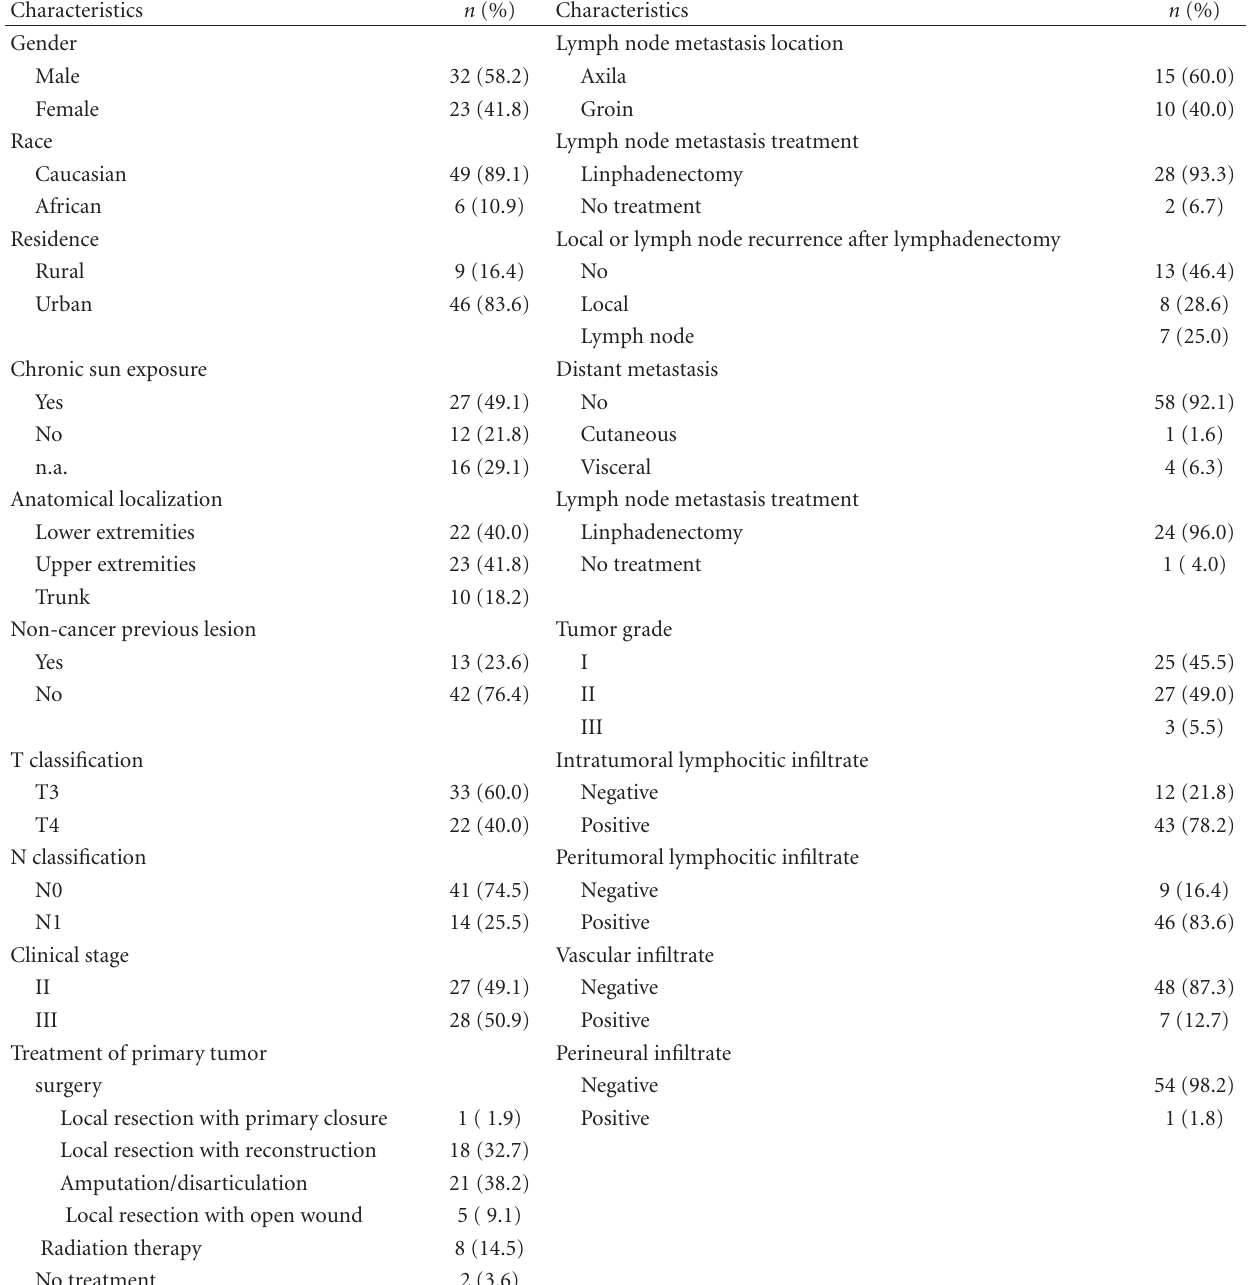
Table 1: Demographic, clinical, therapeutic, and pathological characteristics of patients with locally advanced cutaneous squamous cell carcinoma of trunk and